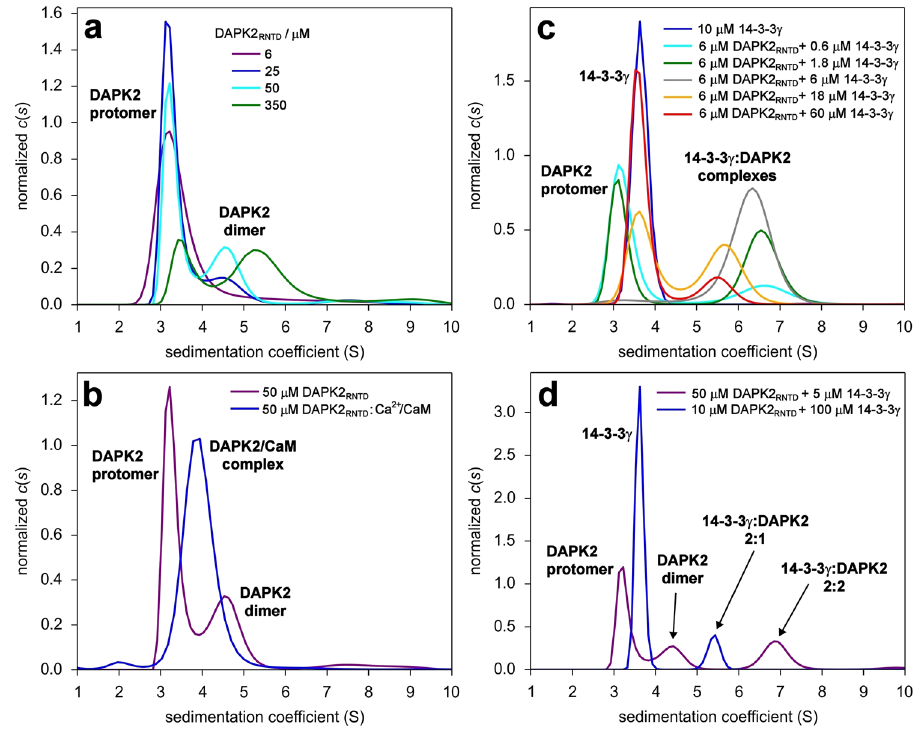
Fig. 3 Sedimentation velocity analytical ultracentrifugation analysis of the DAPK2 RNTD and its interactions with Ca 2 + /CaM and 14-3-3 γ . a Series of area-normalized c ( s ) distributions of DAPK2 RNTD alone at various concentrations. b Comparison of area-normalized c ( s ) distributions of 50 μ M DAPK2 RNTD alone and of a 50- μ M mixture of DAPK2 RNTD with Ca 2 + /CaM (1:1 molar ratio). c Series of area-normalized c ( s ) distributions of mixtures of DAPK2 RNTD and 14-3-3 γ at various molar ratios, using 6 μ M DAPK2 RNTD and 0.6 – 60 μ M 14-3-3 γ . d Comparison of area-normalized c ( s ) distributions of mixtures of DAPK2 RNTD with 14-3-3 γ at 10:1 (violet) or 1:10 (blue) molar